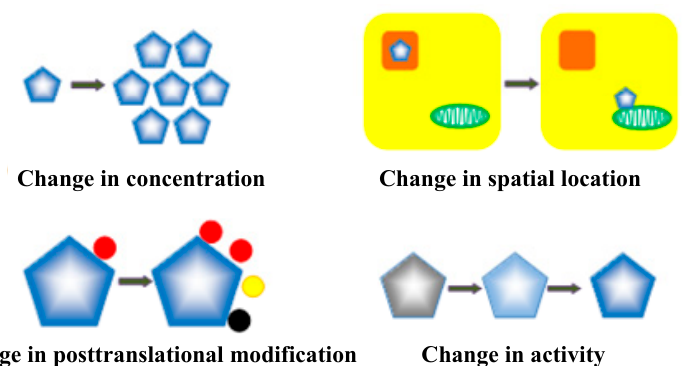
Figure 2. p53 dynamics. p53 dynamics include the changes of p53 protein concentration, activity, localization, or modifications that can be measured over time.